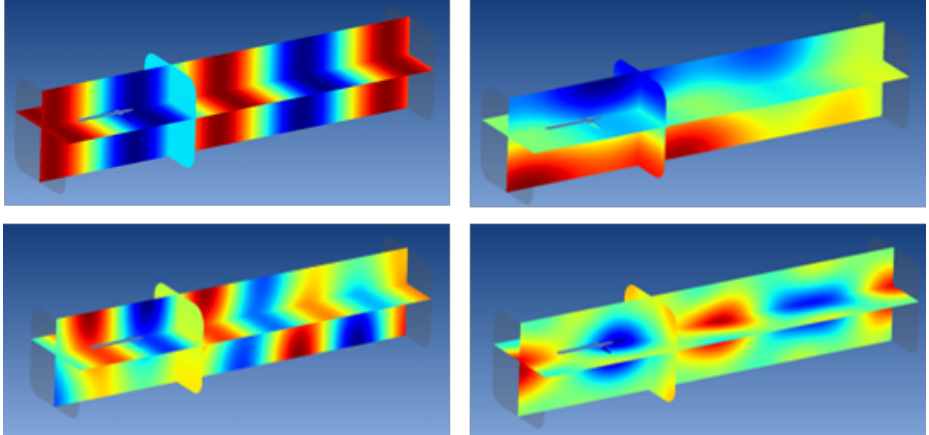
Figure 14. Noise maps: top left, 1000 Hz; top right, 1500 Hz; bottom left, 2000 Hz; bottom right, 3000